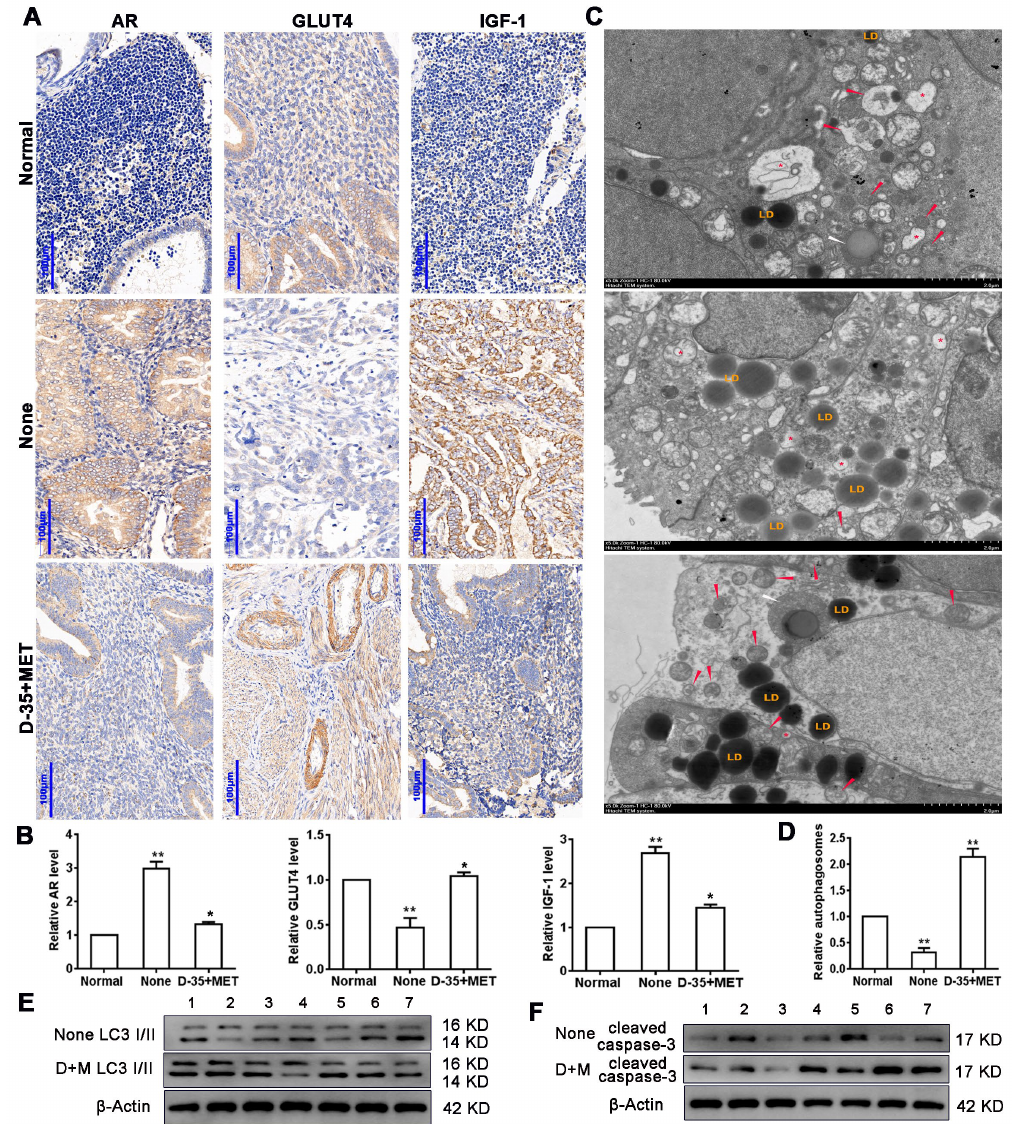
Figure 1. Diane-35 and metformin reduced AR and IGF-1 expression and increased GLUT4 expres- sion in the early-stage tumor tissue of PCOS patients with EC. Immunohistochemistry ( A ) and PCR analysis ( B ) for AR, GLUT4, and IGF-1 in endometrial carcinoma tissue, scale bars = 100 μm. Trans- mission electron microscope analysis of patients’ tissues: autophagosomes: red arrow, autolysosome: white arrow, lysosome: red asterisk, and lipid droplet: LD, scale bars = 2 μm ( C , D ). Western blotting analysis of LC3 I/II ( E ) and cleaved caspase-3 ( F ) expression levels from 7 different patient samples. Data are shown as the mean ± S.D. * p < 0.05 and ** p < 0.01, ANOVA.